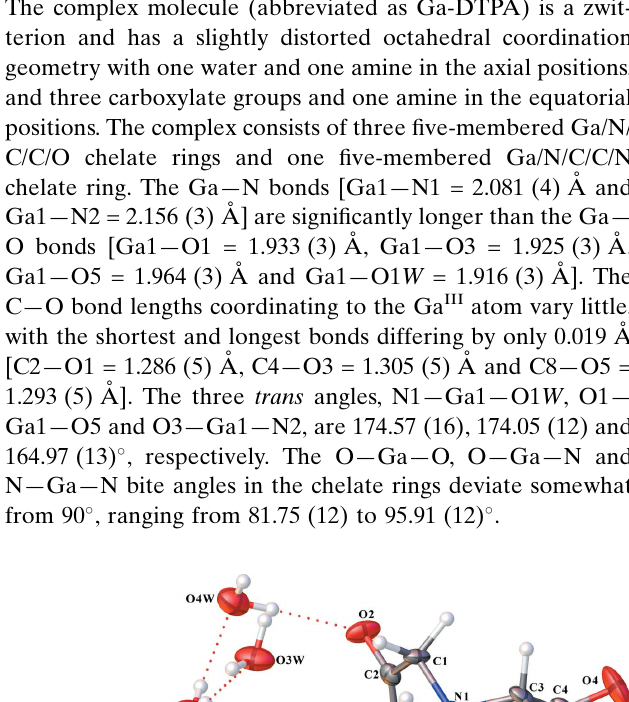
Figure 2 A packing diagram of the title compound, viewed along the a axis.